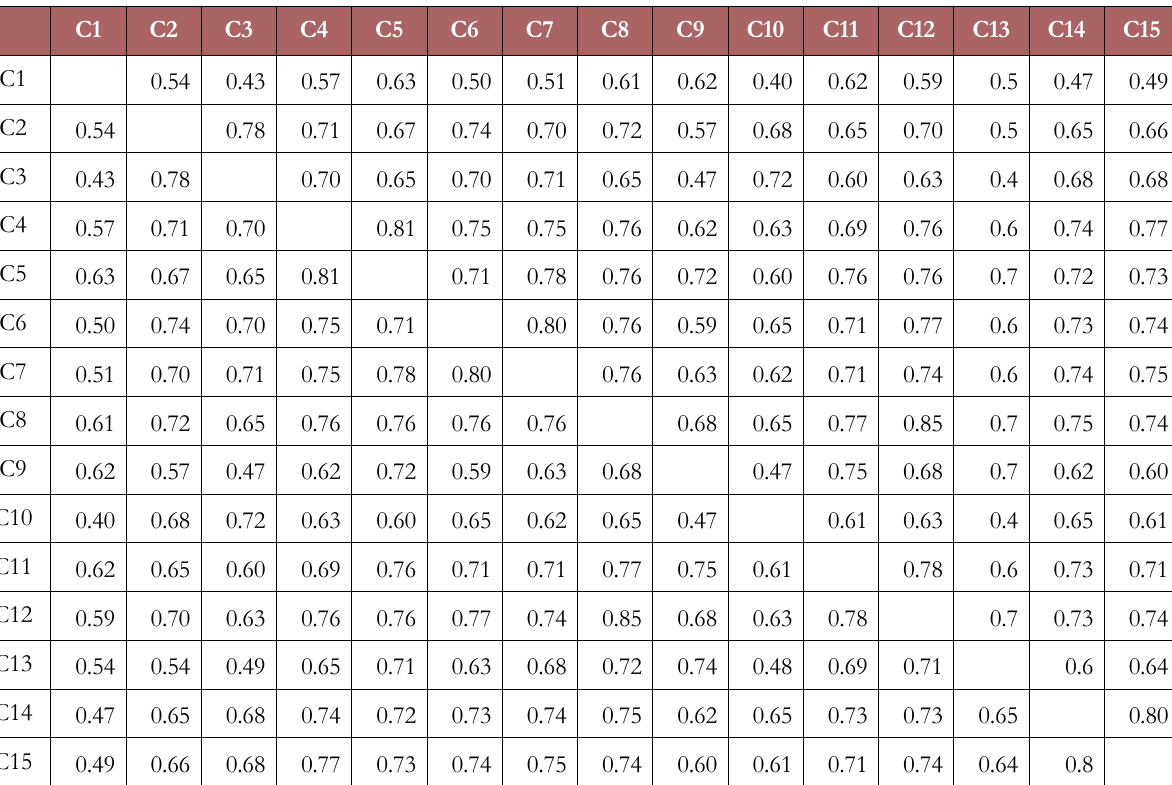
Table 6. Strength of relationship matrix of